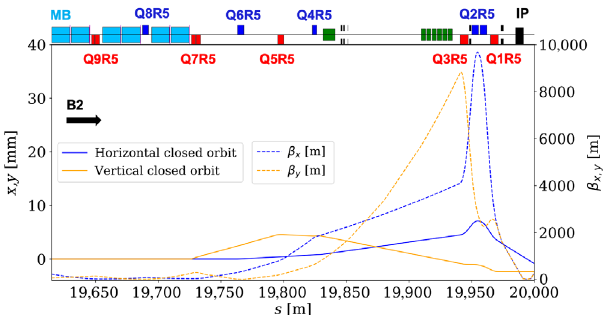
focusing (blue) and defocusing (red) quadrupoles and dipoles (light blue), from the IP to Q9, with the horizontal and the vertical closed orbit and β functions for the 2018 physics configuration optics with β (cid:2) x;y ¼ 25 cm. Note here that the triplet quadrupoles of the final-focus system correspond to Q1R5, Q2R5, and